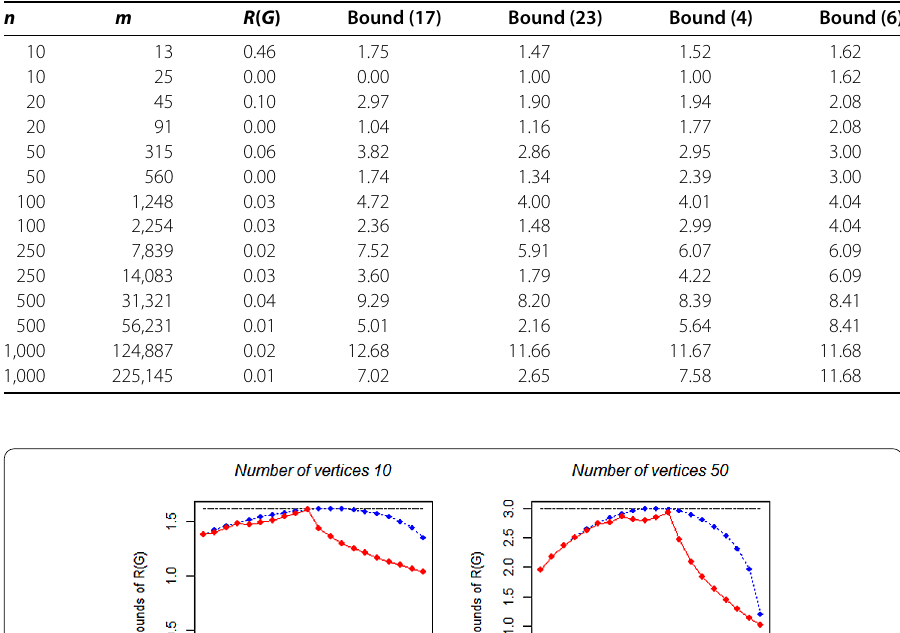
Table 4 Upper bounds of R ( G ) for bipartite graphs